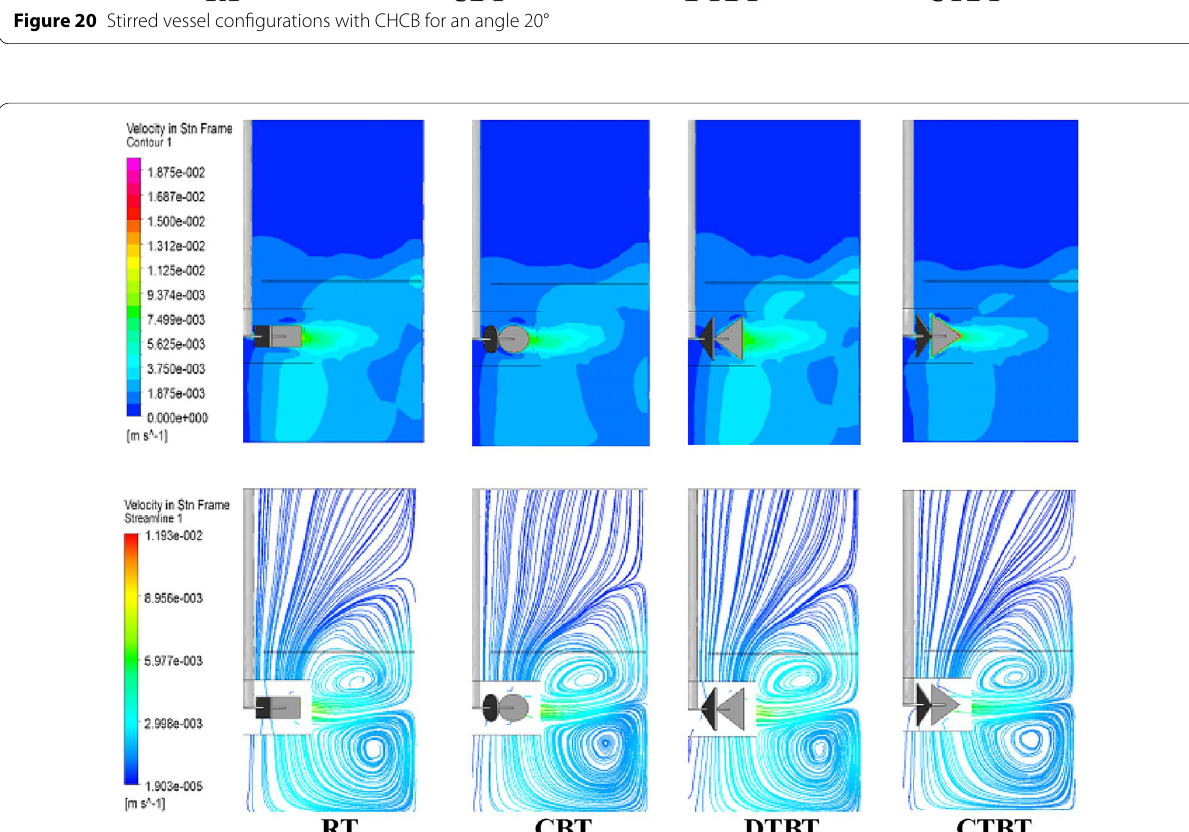
Figure 21 Flow fields for different agitator’s types of baffled tanks with CHCB for an angle 20°, Re